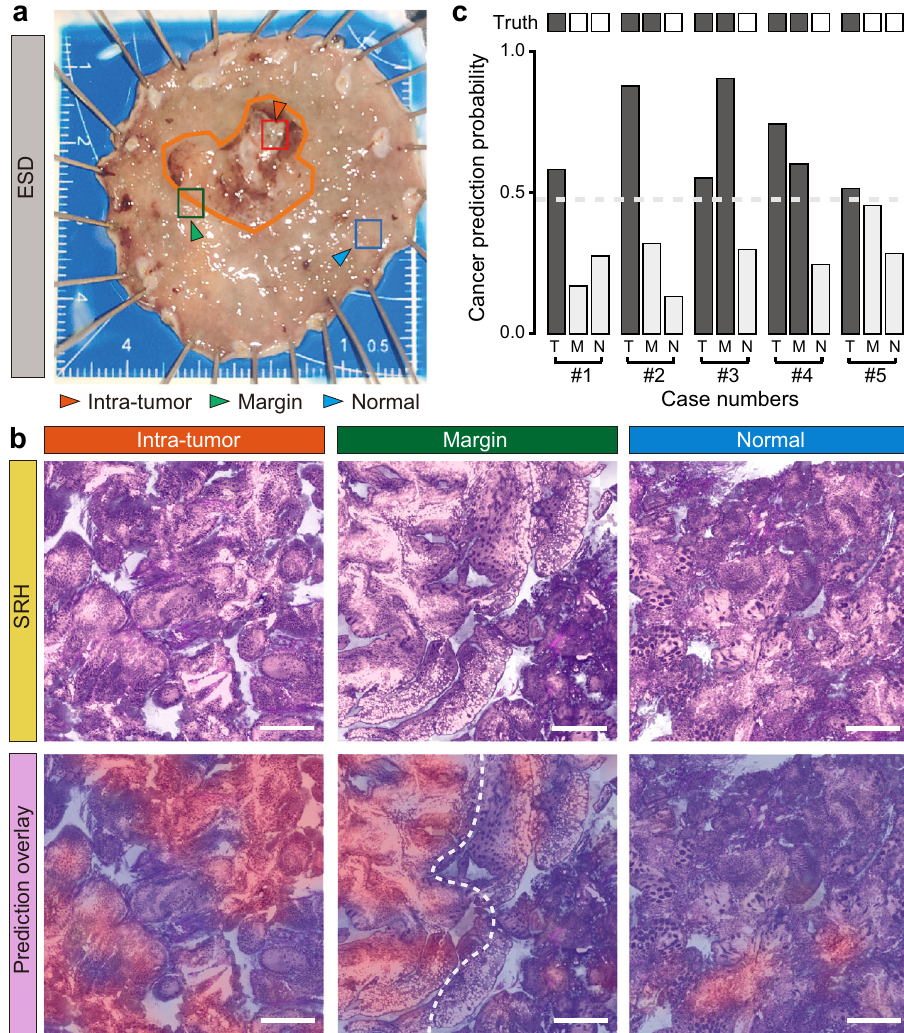
Fig. 7 Simulated intraoperative evaluation of resection margins on endoscopic submucosal dissection (ESD) specimens. a A typical ESD tissue and the three test locations of intra-tumor (T), visual margin (M) and ~8 mm away from the margin (N); b Femto-SRH imaging results of the three test points of a typical case, showing the predicted diagnostic segmentations of cancer (red) vs. non-cancer (blue). c SRH prediction results of the fi ve ESD cases compared with ground truths. Scale bars: 200 µ m. Source data are provided in the Source data fi